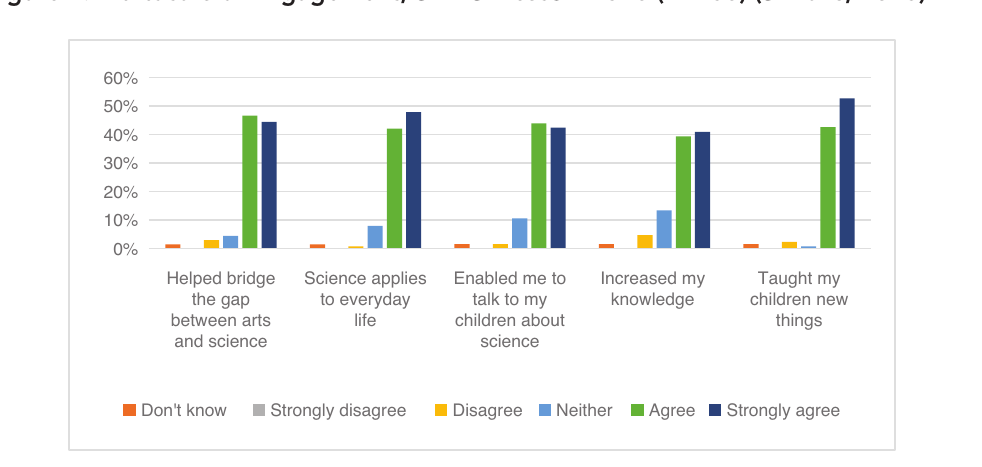
figure 9: Indicators of engagement, sMashfestUK 2018 ( n =188) (simons,